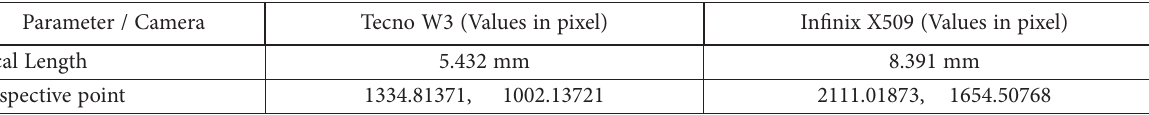
Table 1. Camera calibration for the non-metric cameras used in the